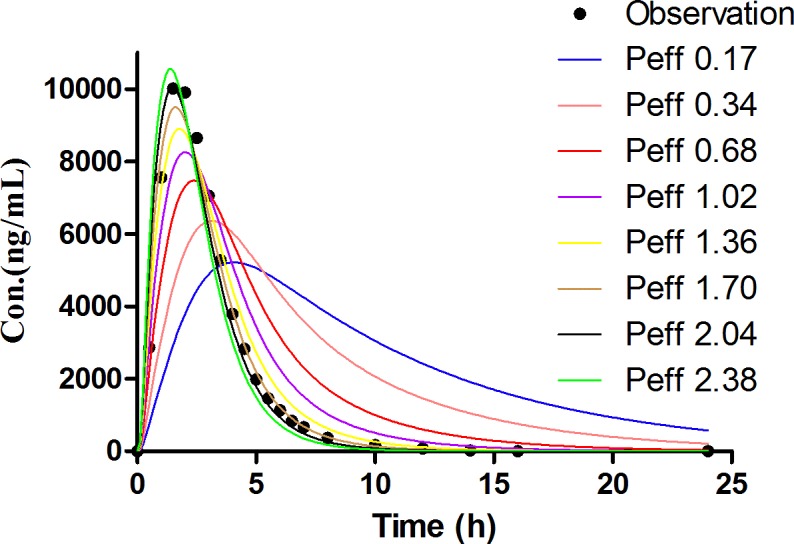
The parameter sensitivity analysis for the effect of Peff,man on the pharmacokinetic profile of amoxicillin suspension (750 mg).